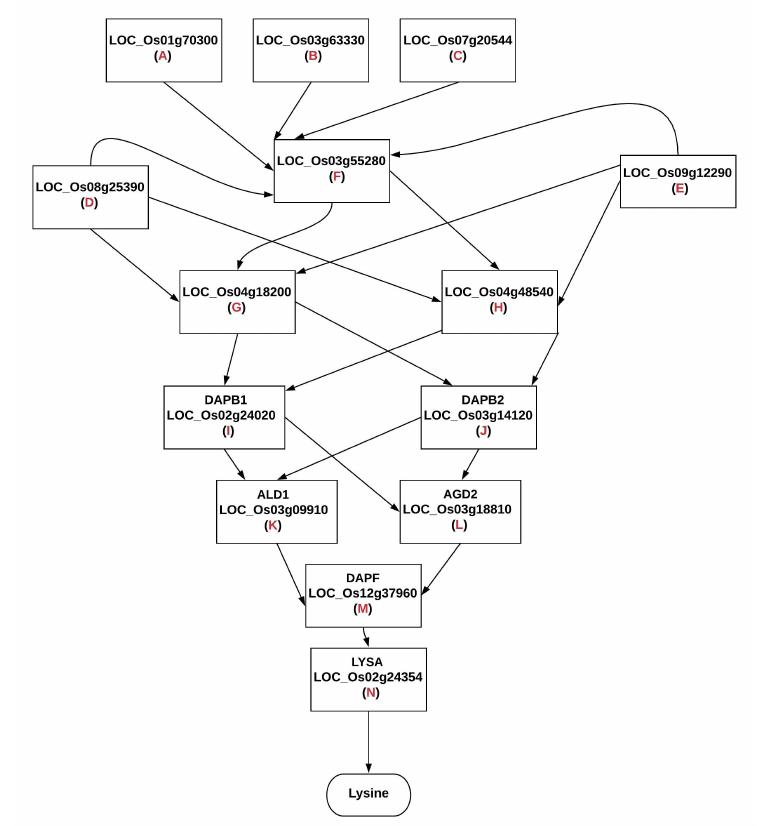
Figure 2. Gene regulatory network for lysine biosynthesis pathway in rice. The gene names are presented according to their MSU IDs. The alphabets in red font are aliases for the respective genes, e.g., LOC_Os01g70300 is referred to as gene A. Genes I–N have been given names in the literature; these have been mentioned in the figure alongside their respective MSU